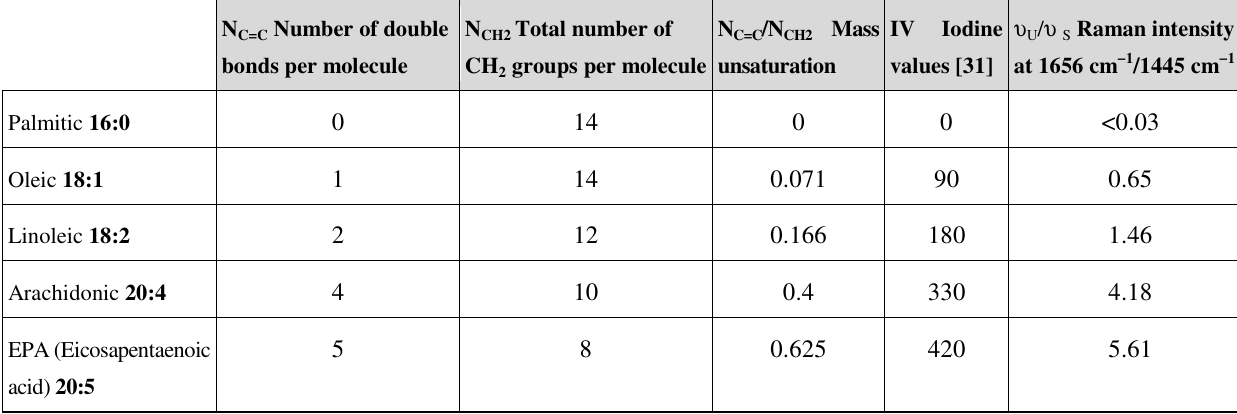
/ ν of the Raman spectral peaks U S /N Crosses mark C=C CH2